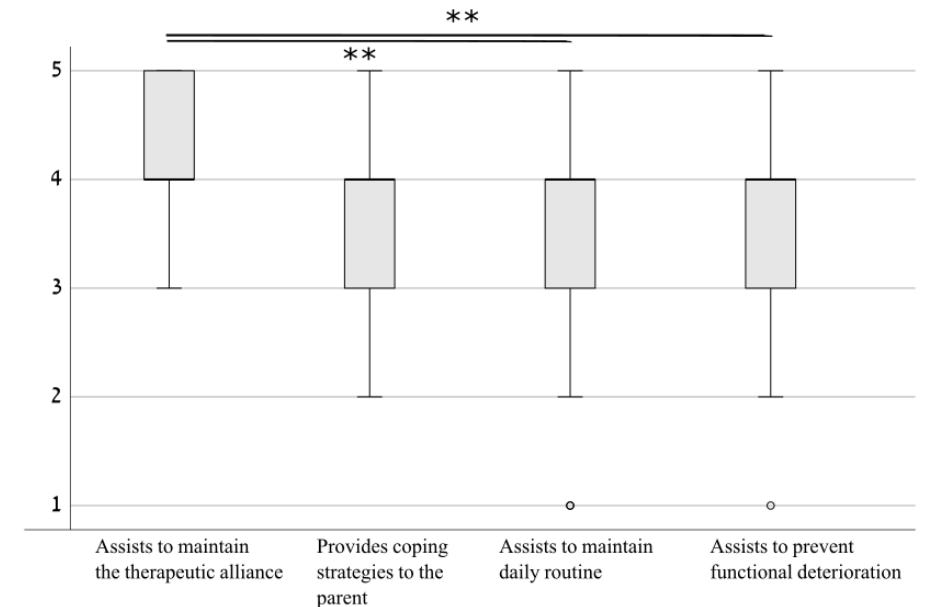
Figure 3. Adherence to pre-defined goals for telerehabilitation. Results demonstrated that the ability to maintain the therapeutic alliance was superior to the ability to assist in maintaining routine and to prevent functional deterioration, and marginally superior to the ability to provide coping strategies to the parent. ** p < 0.01.